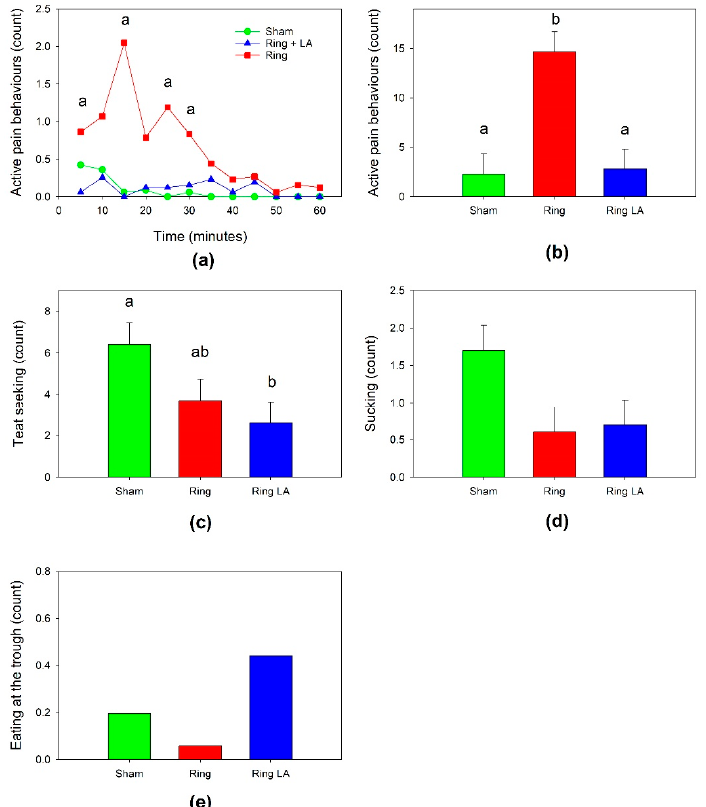
Figure 3. Active pain avoidance behaviors in lambs after tail docking with (Ring LA) or without (Ring) anesthetic, or sham treatment (Sham) in the first hour. ( a ) Count of total active pain behaviors over time (minutes), ( b ) total active pain behaviors (counts over entire duration), ( c ) teat seeking (counts over entire duration), ( d ) sucking (counts over entire duration), and ( e ) eating at the trough (counts over entire duration). Data points with a matching lowercase letter indicate no significant differences between those data points. See text for p values.